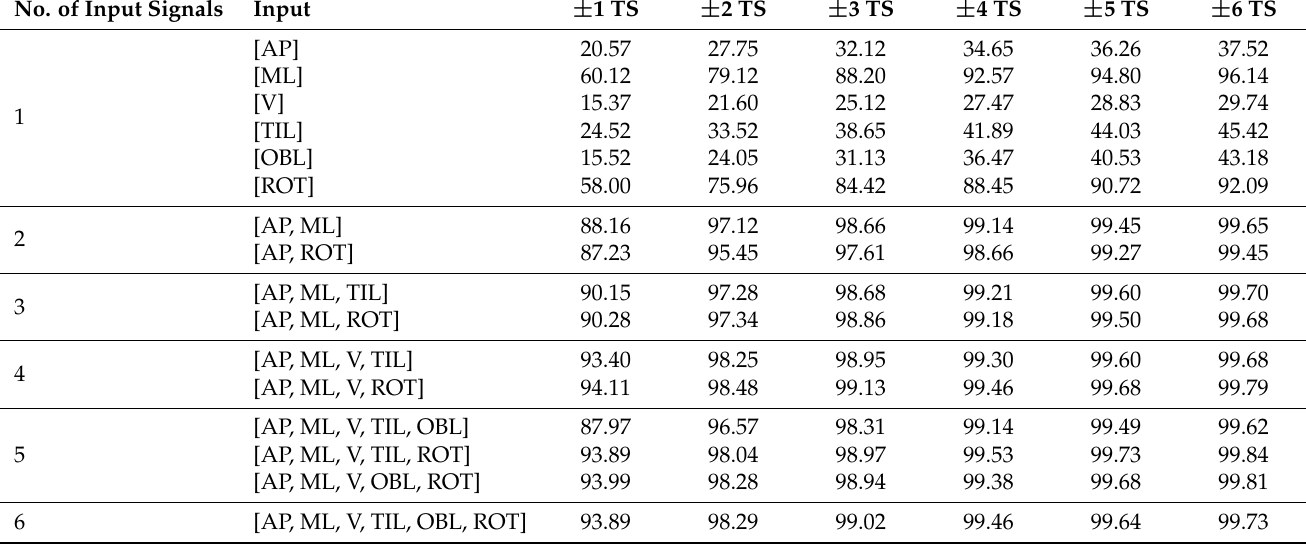
Table 3. Results for ablation study using subsets of input signals.